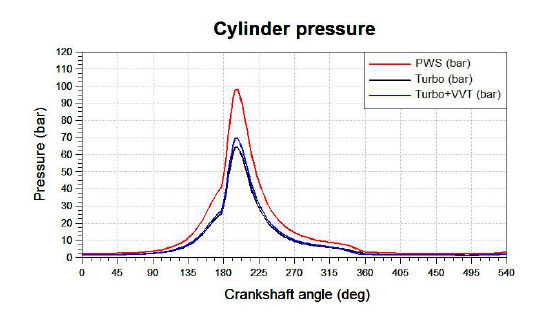
Figure 10. Cylinder pressure for the 3 setups.